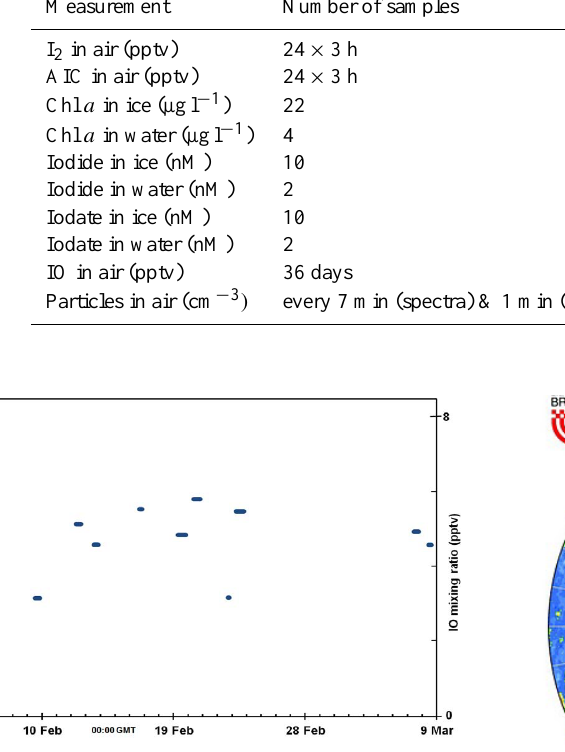
Fig. 4. IO vertical column densities above the sea ice of the Weddell Sea, and their equivalent mixing ratios assuming the IO is well mixed within a boundary layer of height 200 m (see Section 2.2). These values are medians of each sunny day or part-day.